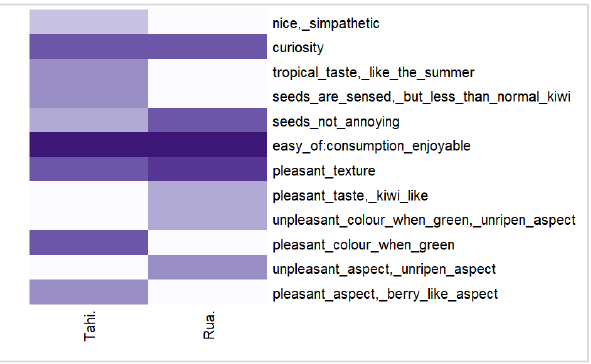
Figure 1. Heatmap 1 of the p -values of descriptive and emotive responses.